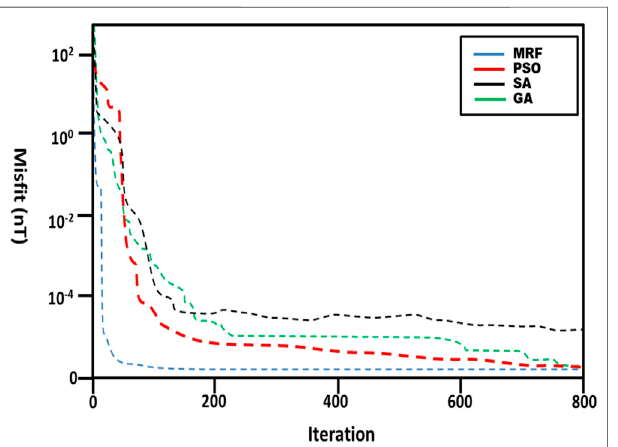
FIGURE9| Curveshowingerrordispersion(Inter-quartile range-IQR)for MRF, PSO, SA and GA.